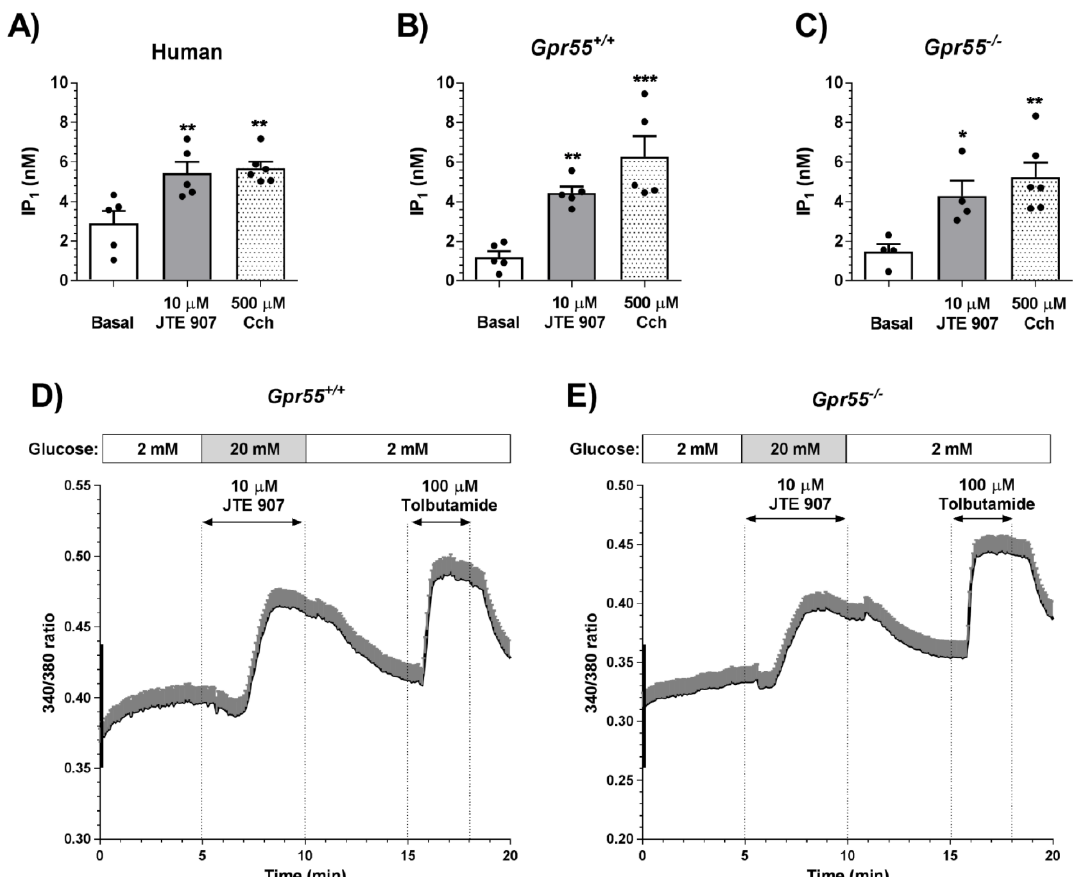
Figure 6. Effects of JTE 907 on IP 1 levels and [Ca 2+ ] i in islets. ( A – C ) 10 µ M JTE 907 significantly elevated IP 1 levels in islets from human donors ( A ) and Gpr55 +/+ ( B ) and Gpr55 − / − ( C ) mice. 500 µ M carbachol (Cch) was used as positive control. Panels A–C show mean + SEM data of 4–6 observations per treatment group that are representative of 3 independent experiments using both mouse and human islets. * p < 0.05, ** p < 0.01, *** p < 0.001 JTE 907 or Cch vs. basal. Data were analysed using one-way ANOVA, followed by Dunnett’s multiple comparisons post-test. ( D , E ) Dynamic profiles of [Ca 2+ ] i in Fura-2-loaded dispersed Gpr55 +/+ ( D ) or Gpr55 − / − ( E ) mouse islet cells. 10 µ M JTE 907 induced [Ca 2+ ] i elevation in the presence of 20 mM glucose in both Gpr55 +/+ and Gpr55 −/− islet cells. The horizontal arrows indicate the period of perifusion with JTE 907 or the sulphonylurea tolbutamide, which was used as a positive control. Data of the 340/380 fluorescence ratios are expressed as mean + SEM of 68 ( D ) and 74 ( E ) islet cells from 3 independent experiments with Gpr55 +/+ or Gpr55 − / − mouse islets.